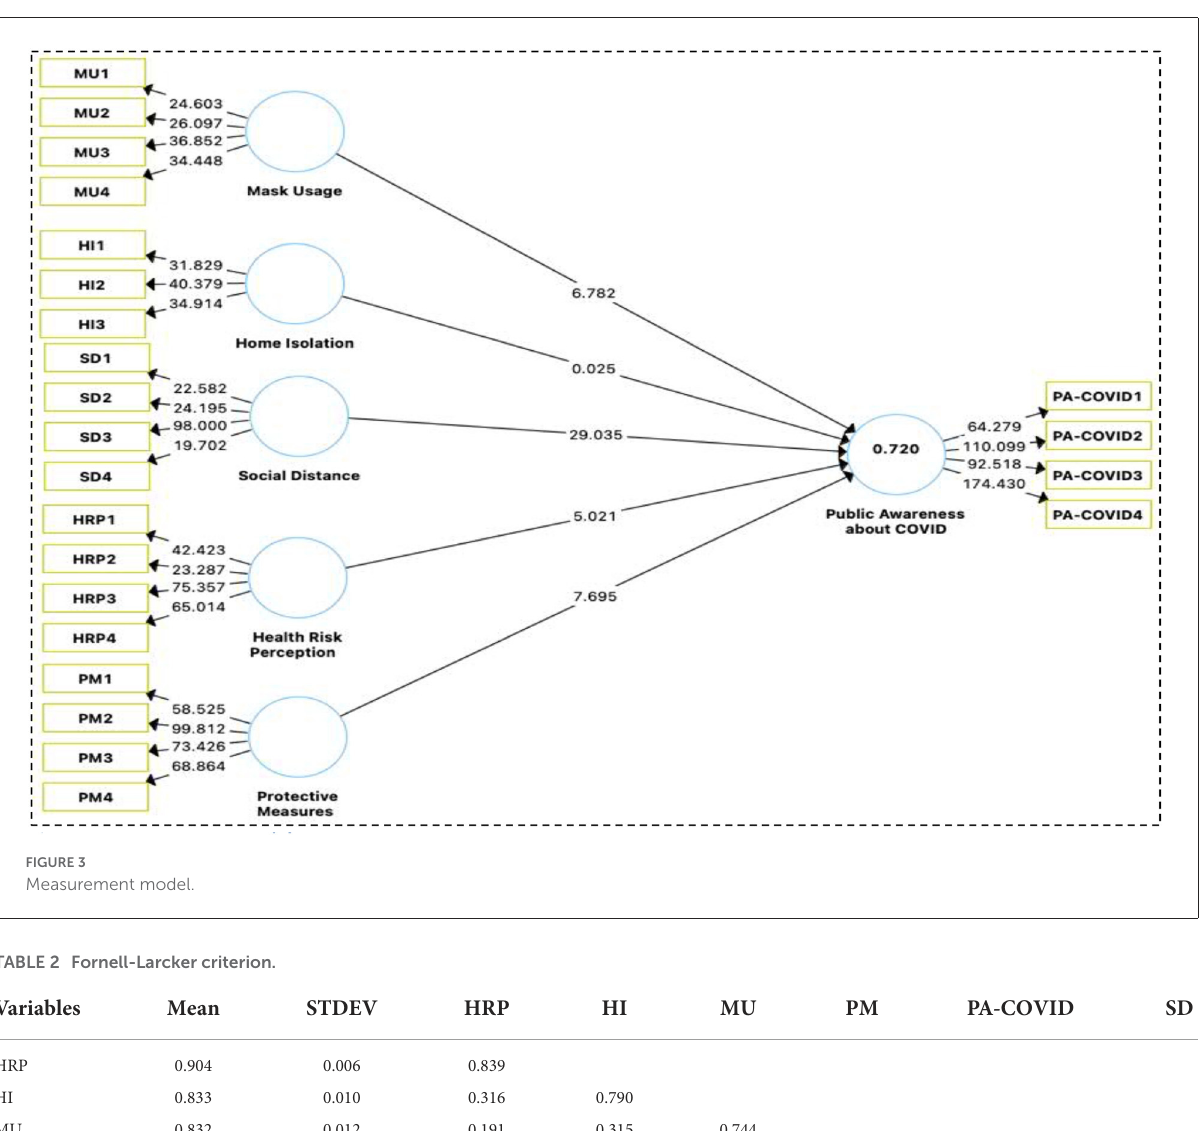
TABLE 2 Fornell-Larcker